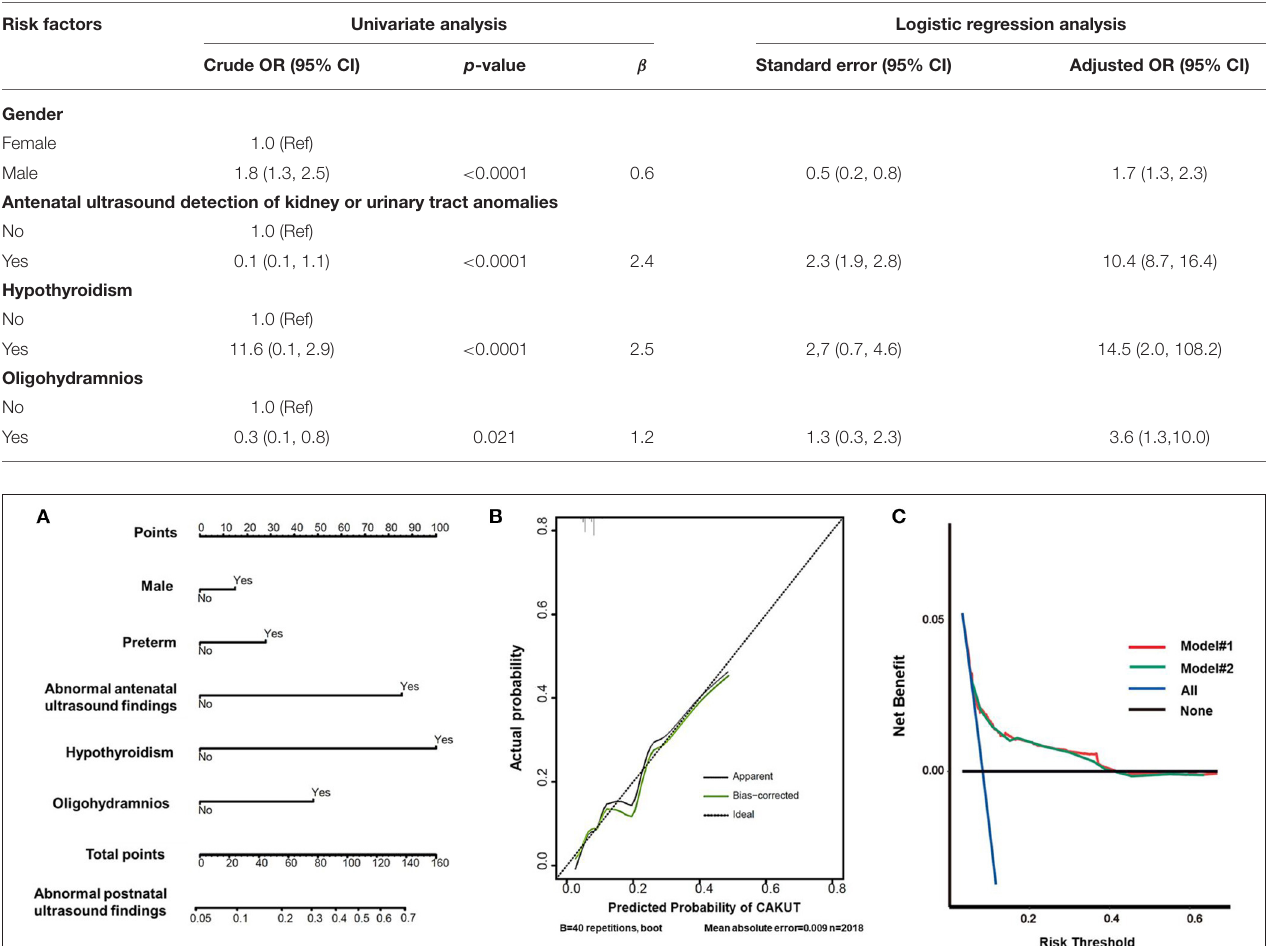
TABLE 3 | Association between the identified risk factors and kidney and urinary tract anomalies screened by postnatal ultrasound scanning in full-term neonates. Risk factors